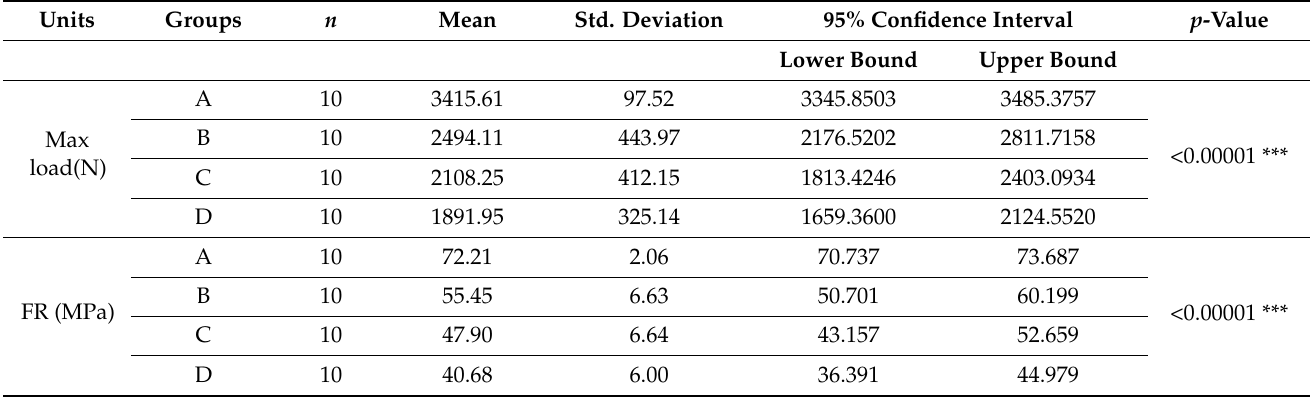
Table 2. Comparison between groups using one-way